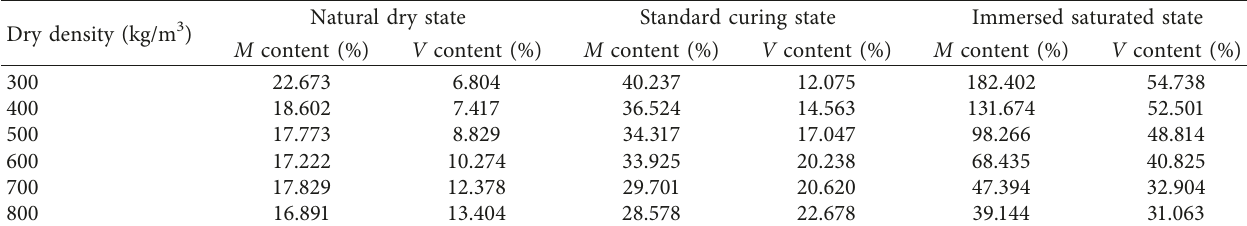
Table 3: The moisture contents of foamed concrete in different moisture states.